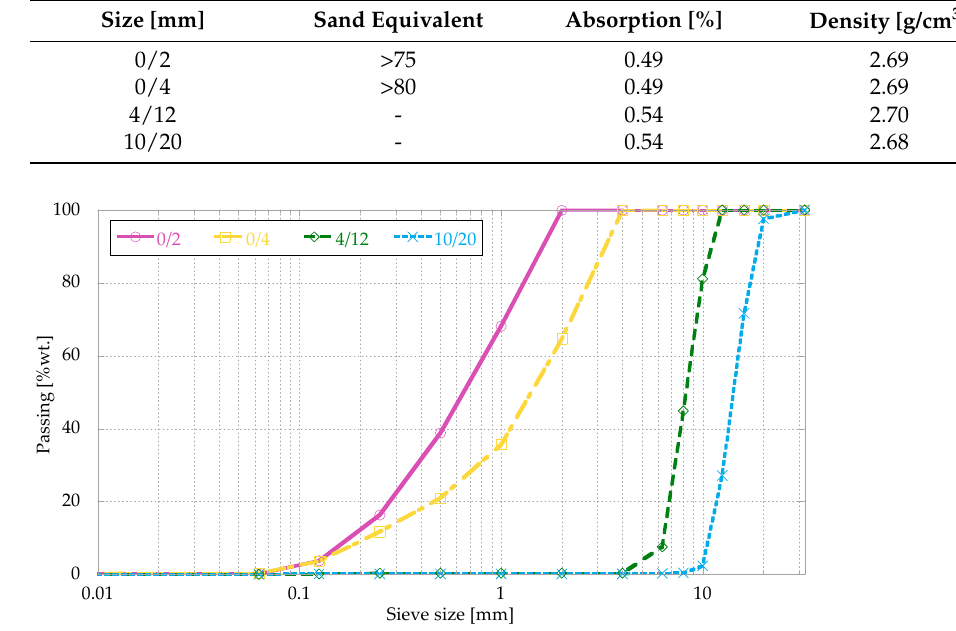
Figure 2 . Grading curve. Figure 2. Grading